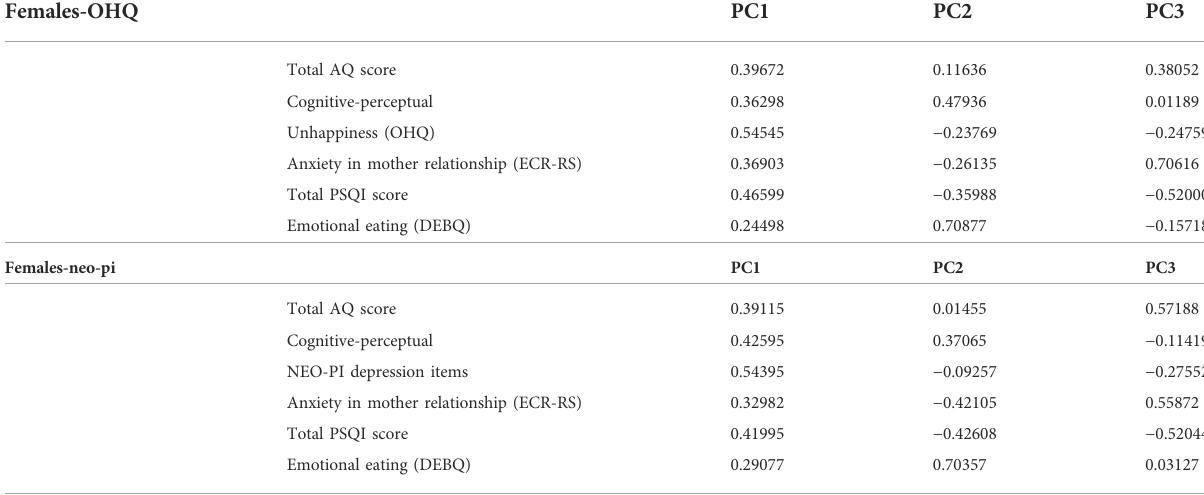
TABLE 5 Loadings for each variable across the three largest principal components in the subdivided analyses limited to females ( N = 190). Females-OHQ